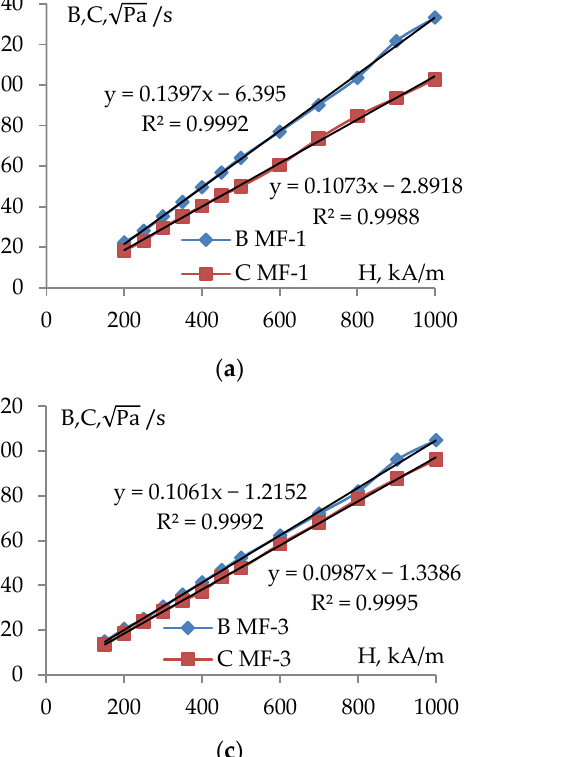
y = 0.1397x − 6.395